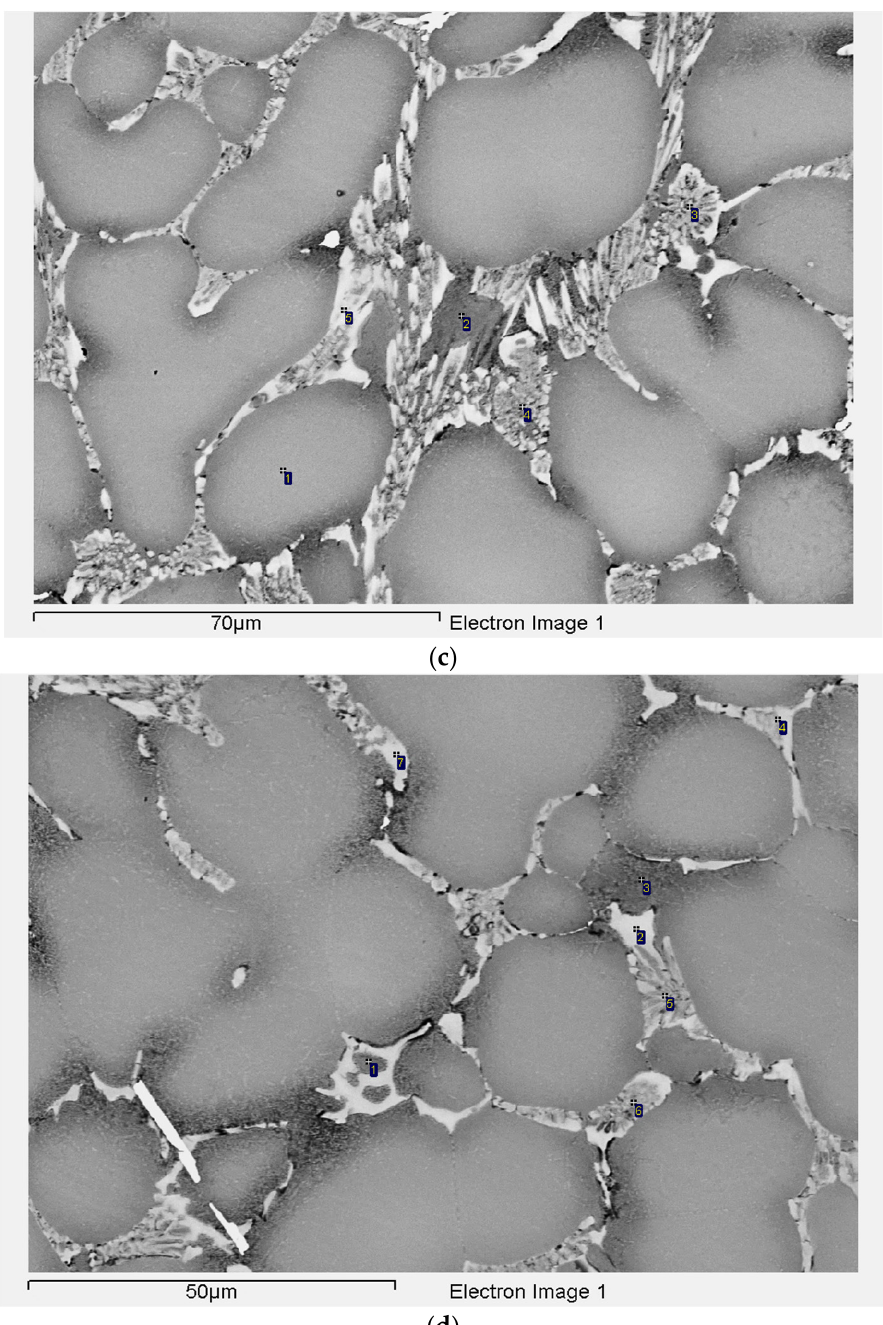
Figure 7. BSE images of the microstructure of NV1 after isothermal oxidation at 800 °C. ( a ) Oxide scale, interface between scale and substrate and bulk of oxidised specimen, 1 scale, 2–8 Nb ss , Nb 5 Si 3 is the bright contrast phase. ( b ) Oxide scale and interface between scale and substrate, 1–3 and 11 Nb 5 Si 3 , 4 to 9 Nb ss , 10 and 13 Si-rich oxide, 12 Nb- and Ti-rich oxide; the thin white contrast phase at the interface of Nb-and-Ti-rich oxide with Nb ss on the left-hand side of analysis 11 is the Sn-rich phase; see text. ( c ) Bulk microstructure: 1 Nb ss ; 2 oxidised Nb ss ; 3, 4 oxidised lamellar microstructure; 5 Nb 5 Si 3 . ( d ) Bulk microstructure: 1, 3 Nb ss ; 2, 7 Nb 5 Si 3 ; 5, 6 oxidised lamellar